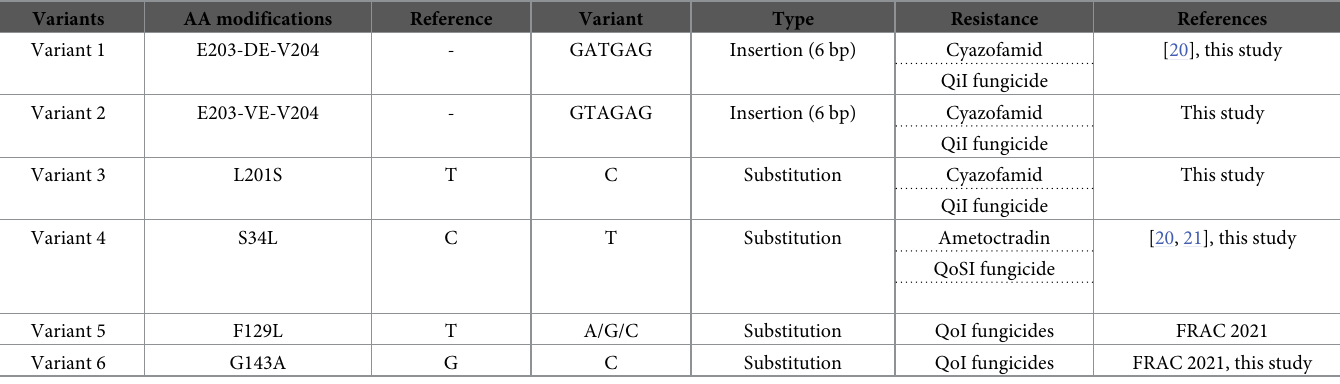
Table 2. Description of P . viticola variants of cyt b gene and associated resistance to cyazofamid, ametoctradin or QoI fungicides considered in this